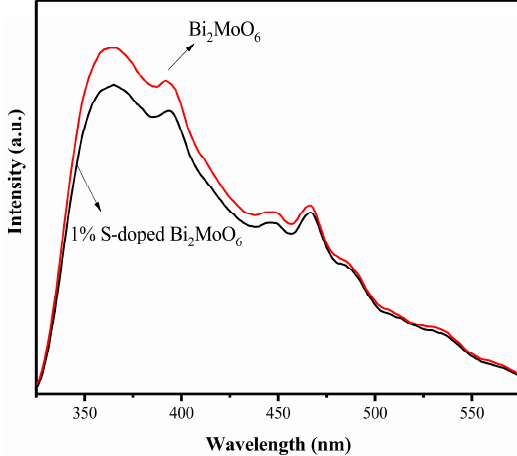
Figure 6. Photoluminescence (PL) spectra of Bi 2 MoO 6 and 1% S-doped Bi 2 MoO 6.